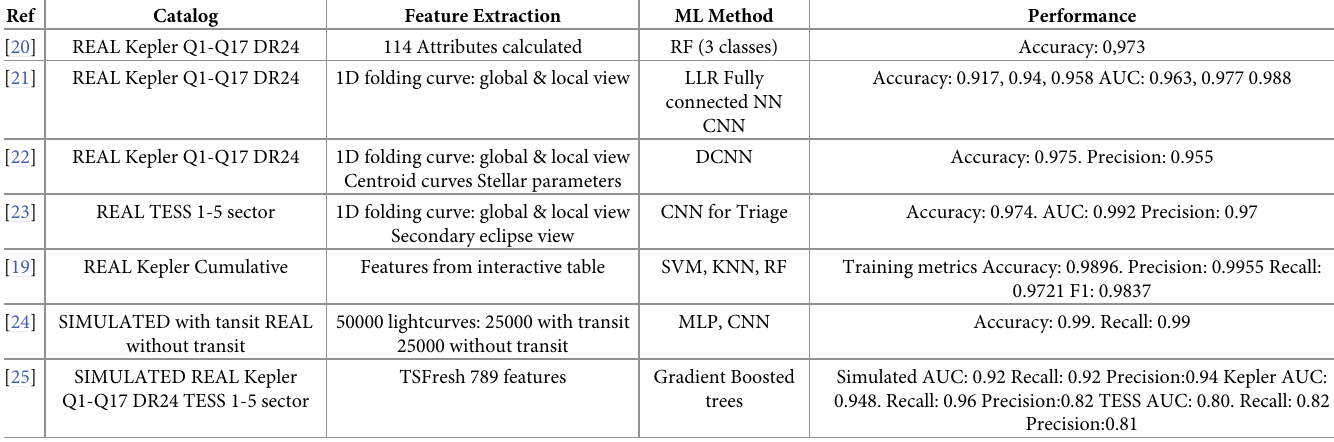
Table 1. Machine learning approaches for exoplanet